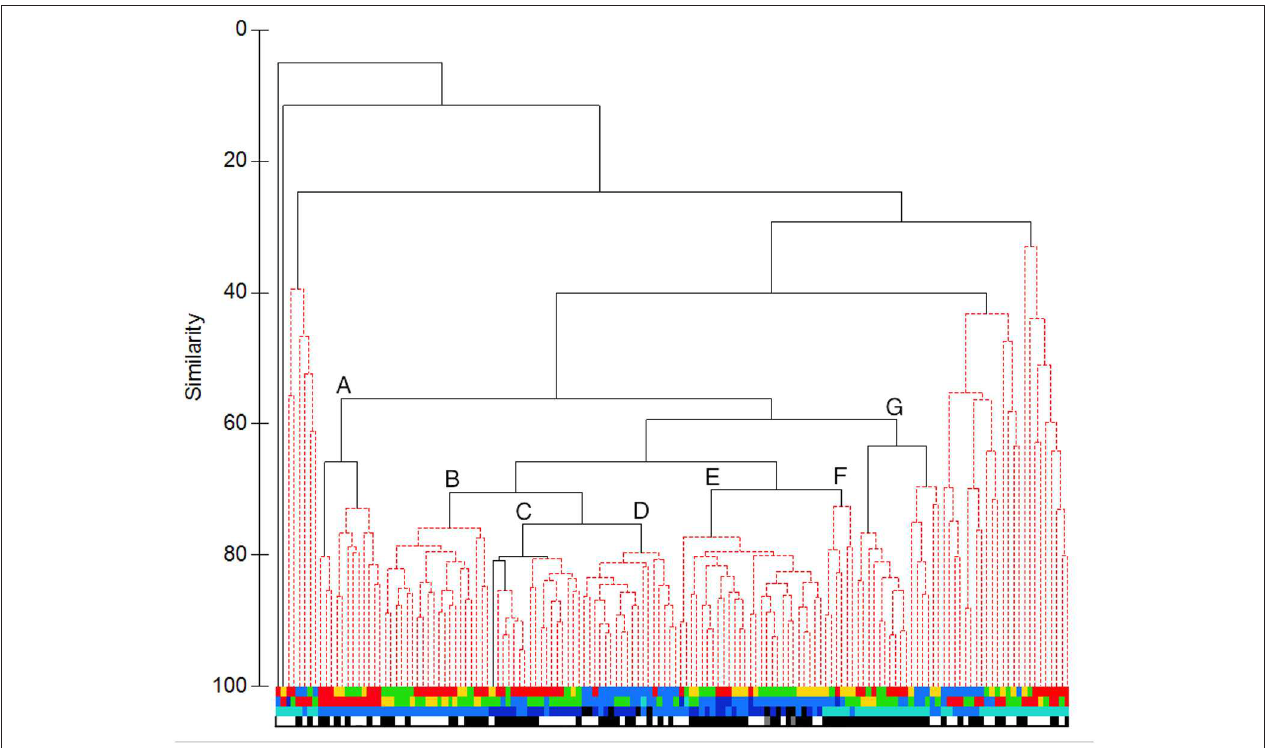
FIGURE 5 | UPGMA cluster of sets based on catch data in numbers: Clusters significant at P = 0.05 are highlighted in red. Letters identify the major clusters described in the text. The sets are identified by four bands of colour coding: Top band: survey, second band: station, third band: maximum depth reached, bottom band: diel phase (colour coding as in Figure 3 , except for bottom band, where: white: daylight, black: night, grey: sets that spanned sunset).